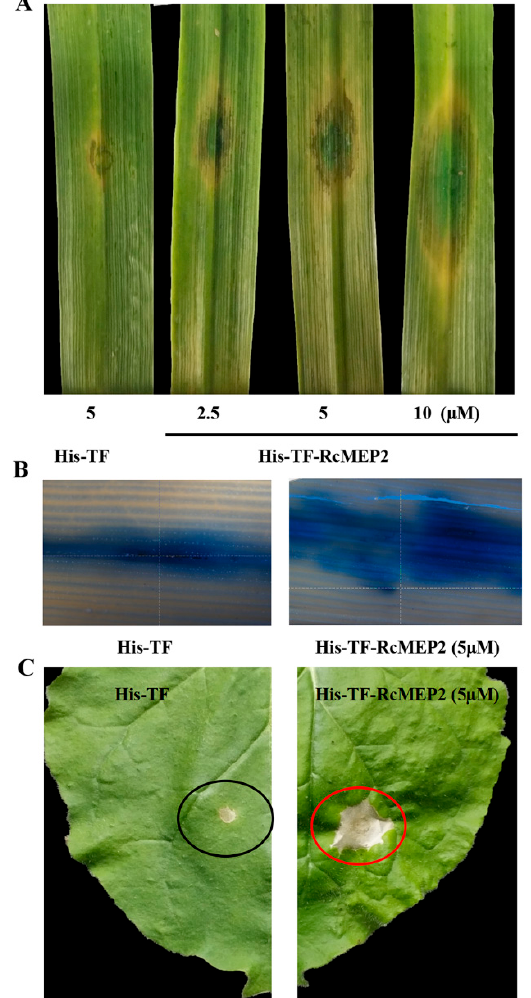
Figure 4. The cell death-inducing activity of RcMEP2 in the protein-infiltrated leaves of wheat and N. benthamiana . ( A ) Leaves of a susceptible wheat cultivar Wenmai 6 at three days after infiltration with the His-TF-RcMEP2 (2.5, 5, and 10 µM) or the His-TF-tag solution (5 µM) as control. ( B ) Trypan blue staining of wheat leaves infiltrated with His-TF-RcMEP2 or the control. Dead wheat leaf cells were stained by trypan blue. ( C ) The necrosis on N. benthamiana leaves infiltrated with His-TF-RcMEP2 (5 µM). The red and black circles indicate cell death induced by His-TF-RcMEP2 and unobvious cell death with His-TF control, respectively.